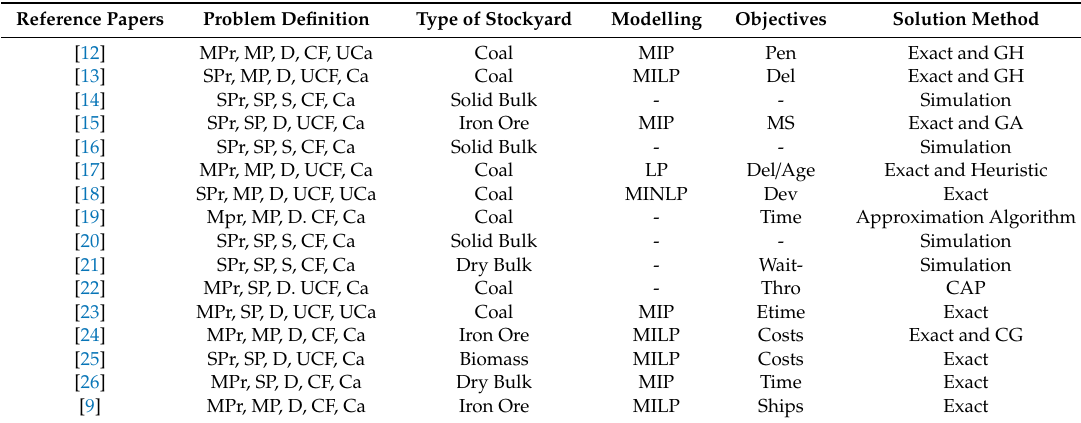
Table 2. Summary of reviewed articles in this